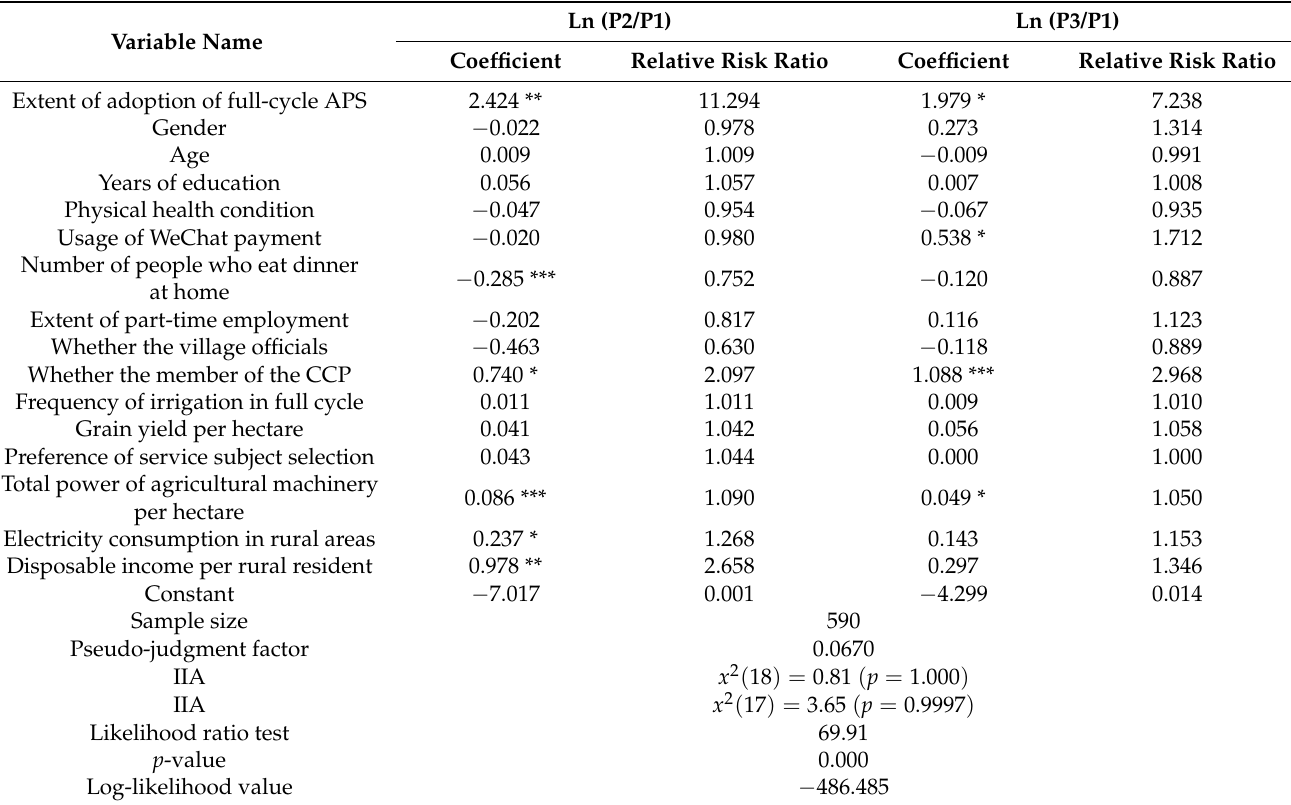
Table 3. Estimation results of mlogit model of willingness to adjust agricultural production methods.